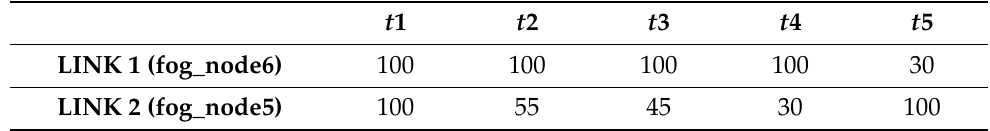
Table 3. Throughput on link1 and link2 (Mbps).